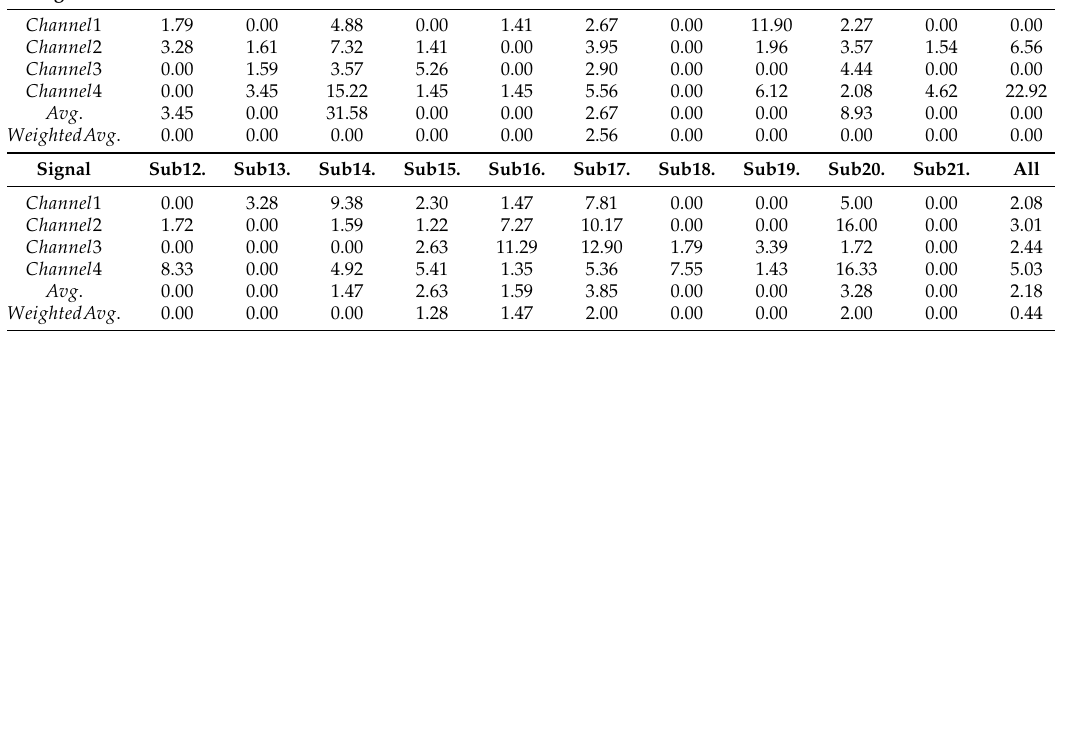
Table 5. Failed detection rate (%) of each subject for browsing.